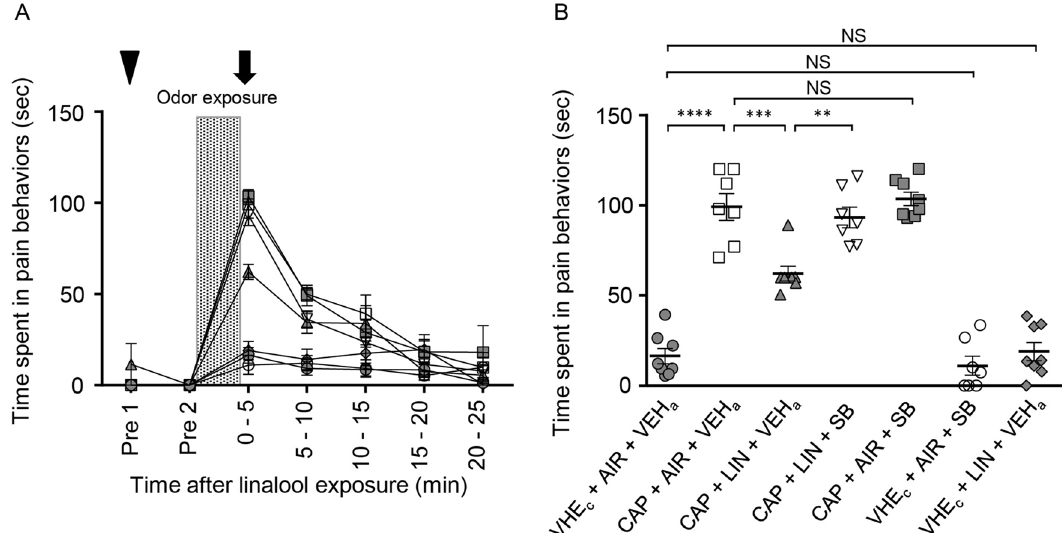
Figure 7. Suppression of capsaicin-induced pain behavior by linalool odor exposure was antagonized by intrathecal administration of orexin 1 receptor antagonist. ( A ) Values represent the time spent in pain behavior as mean ± SEM. The shaded area indicates odor exposure. Arrow and arrow head indicate the timing of intra-tail capsaicin injection and intrathecal SB-334867 injection. White square shows; CAP + AIR + VEH a , White inverted triangle shows; CAP + LIN + SB, White circle shows; VEH c + AIR + SB. Gray circle shows; VHE c + AIR + VEH a , Gray triangle shows; CAP + LIN + VEH a , Gray square shows; CAP + AIR + SB, Gray rhombus VHE c + LIN + VEH a . ( B ) Time spent in pain behavior during the first 5 min after the capsaicin test are re-plotted. n = 7 for CAP + AIR + VEH a , CAP + LIN + SB, VEH c + AIR + SB group, and n = 8 for VEH c + AIR + VEH a , CAP + LIN + VEH a , CAP + AIR + SB, VEH c + LIN + VEH a group. AIR; odorless air exposed mice, LIN; linalool odor-exposed mice, VEH c ; mice which received subcutaneous injection of vehicle for capsaicin, CAP; mice which received subcutaneous injection of capsaicin, VEH a ; mice which received intrathecal injection of vehicle for antagonist, SB; mice which received intrathecal injection of 1 nmol OX1 receptor antagonist. Bars represent mean ± SEM. **** p < 0.0001, *** p < 0.0005, ** p < 0.005 (Sidak’s multiple comparison